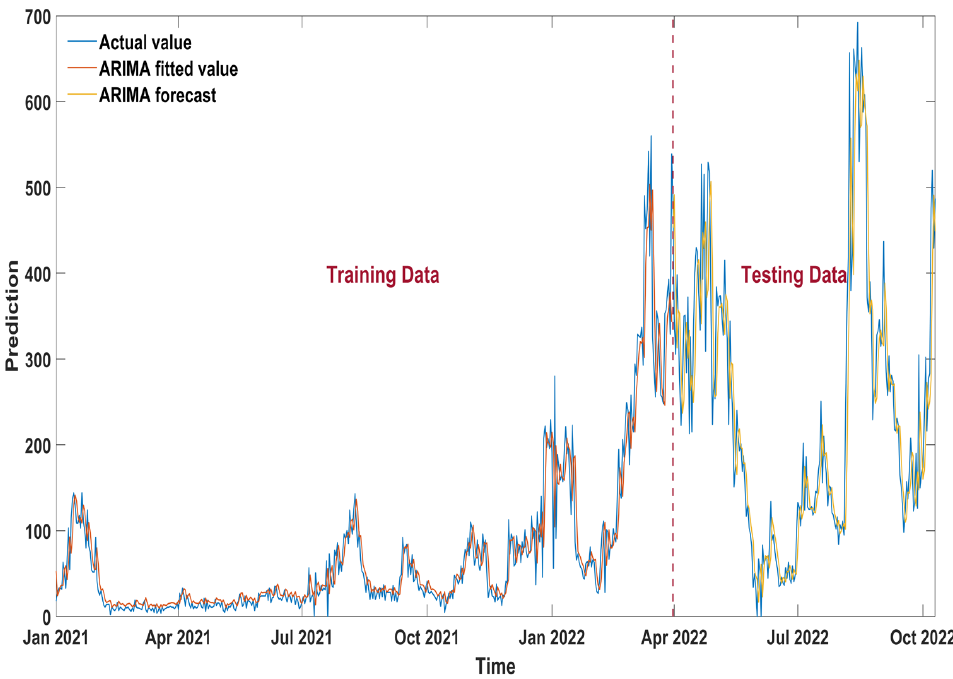
Figure 3. ARIMA fitting effect.